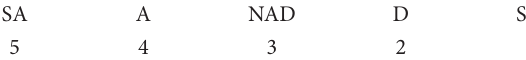
Table 5: Scale from the Matched Pair Instrument assessing physician-patient communication behaviors.